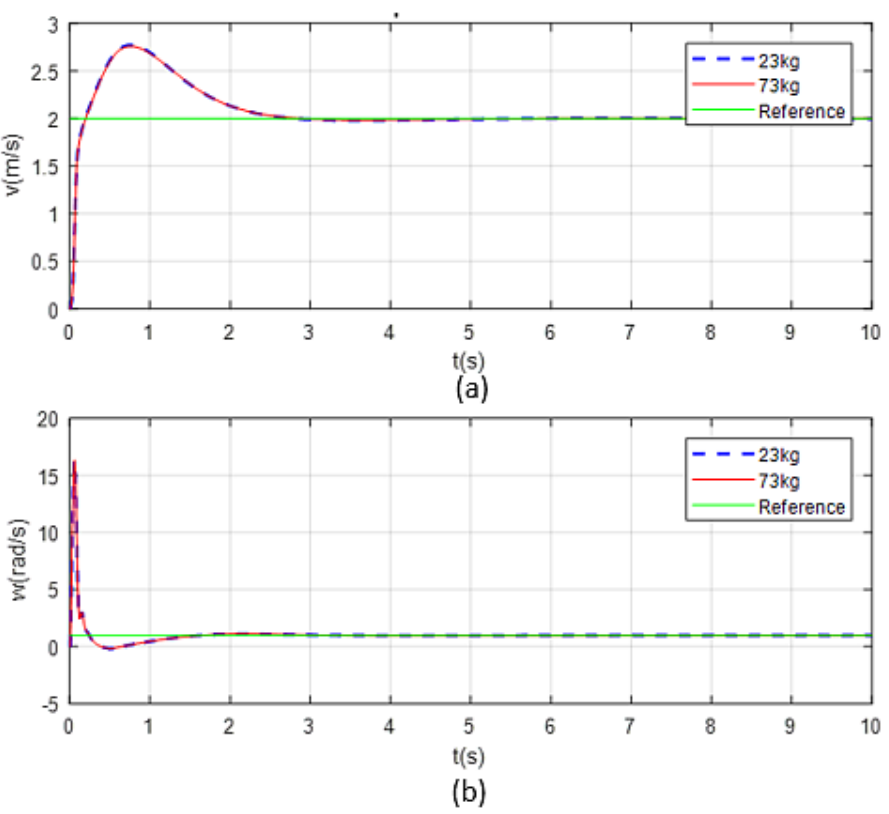
Figure 4. Result of tracking circular trajectory under varying loads.